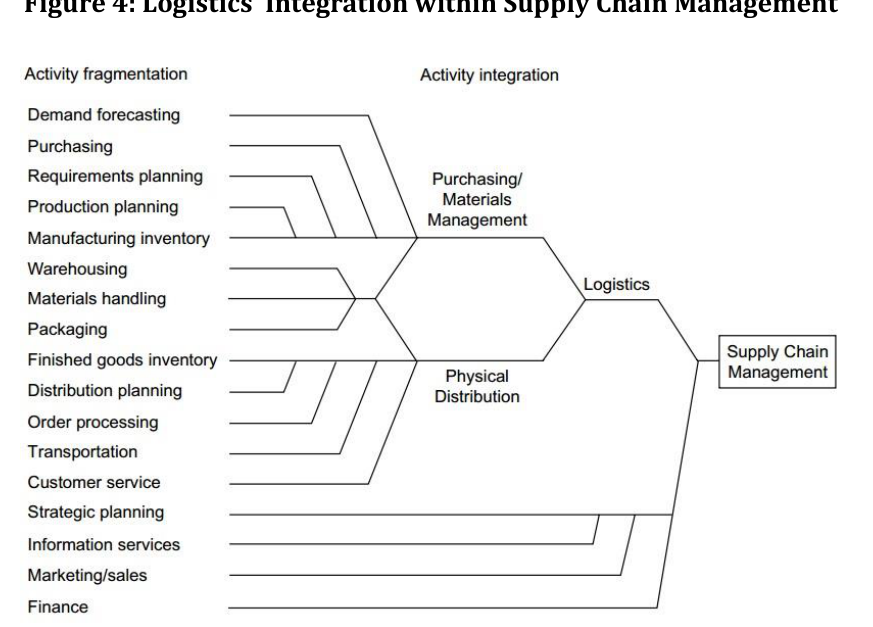
Figure 4: Logistics’ Integration within Supply Chain